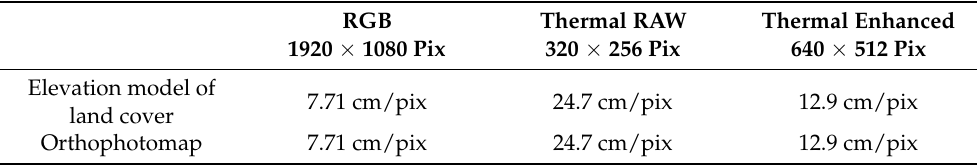
Thermal Enhanced 640 × 512 Pix